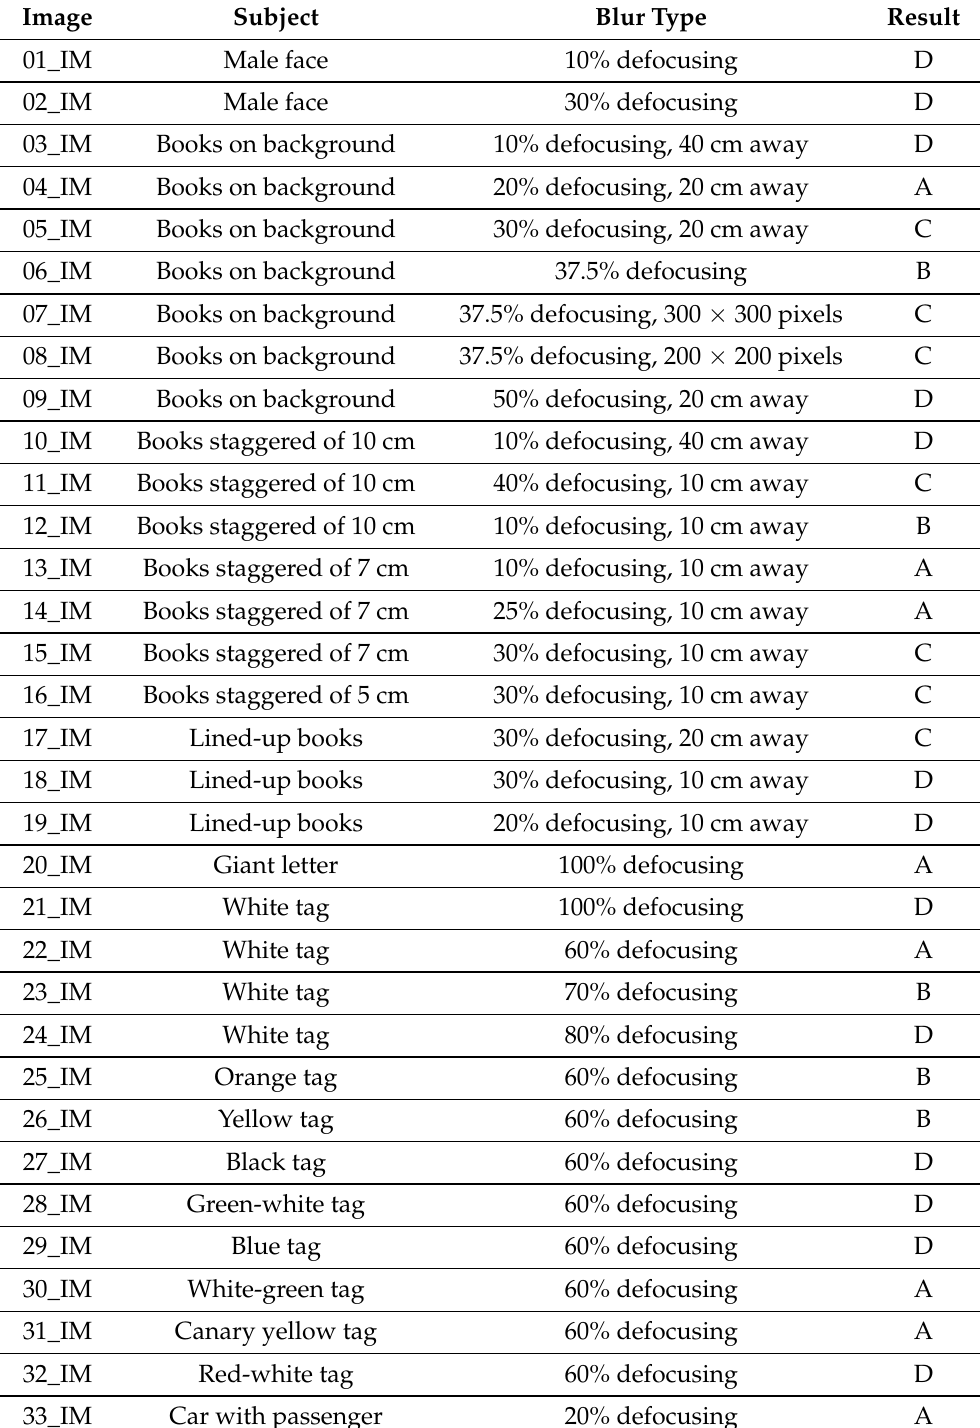
Table 2. Deblurring results on a set of 33 test images included in the first comprehensive set of